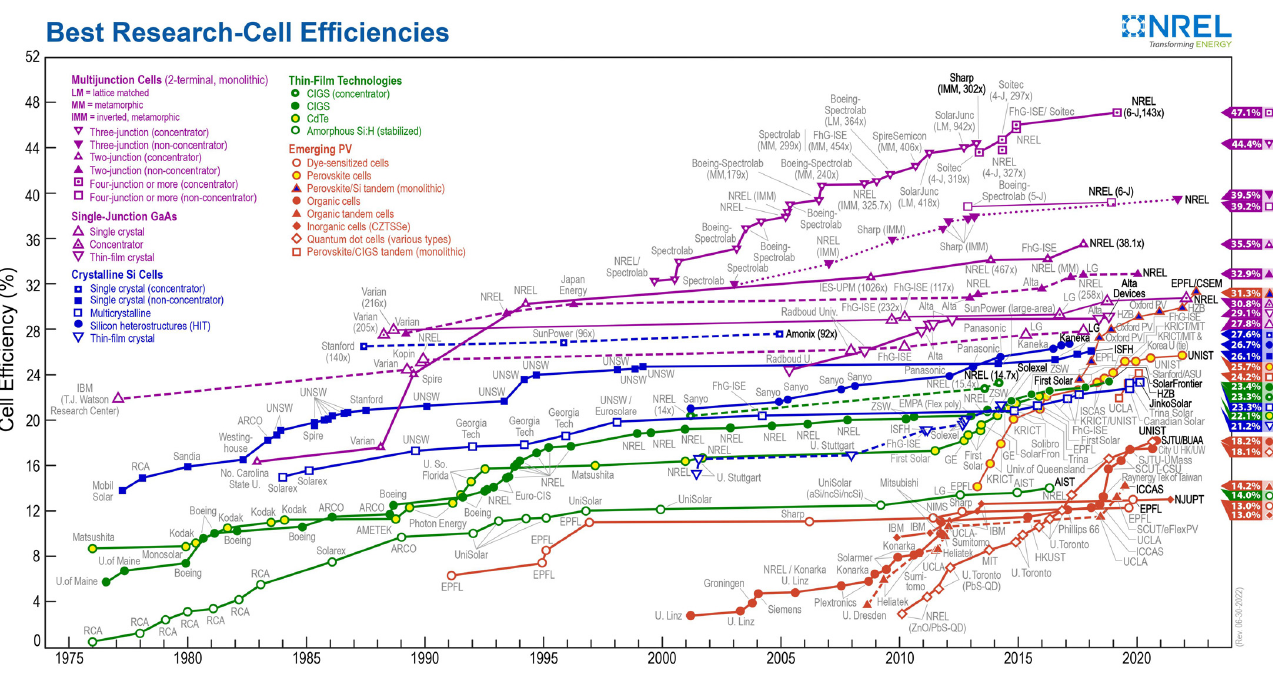
Figure 1. NREL Best Research-Cell Efficiencies chart [11].